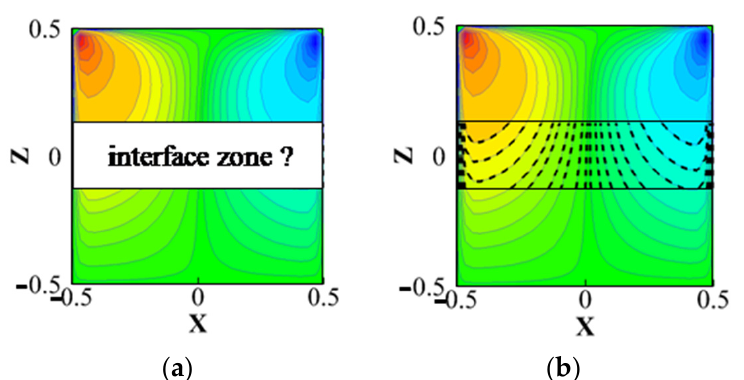
Figure 3. Example of machine learning for an unsteady, 3D cavity flow (The fluid inside a cubic box in size of 1 × 1 × 1 is initially stationary and then starts to flow due to motion of the top wall at speed of cos(2 π t)). Re = 400, and t = 0.25. Solid lines—data, dash lines—prediction. Tensorflow is used [80]. ( a ) Training data. ( b ) Data and prediction.